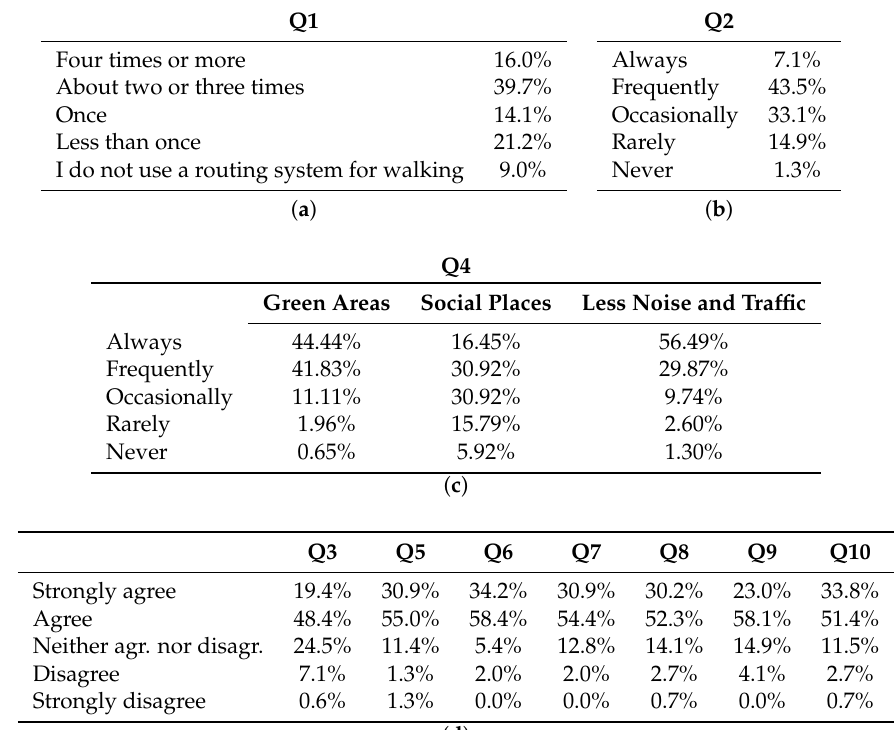
Table 6. Results from the user perception analysis undertaken based on an user-survey. Questions 1 to 10 (Q1–Q10) are presented in Section